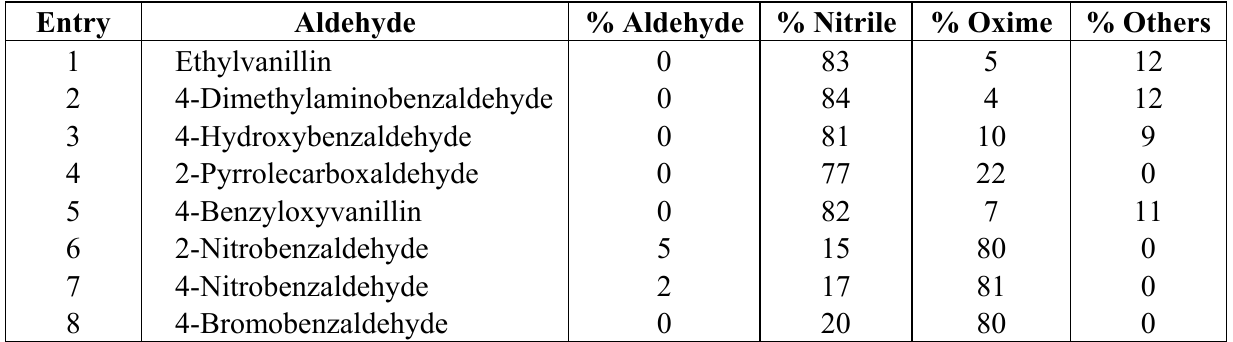
Table 2. Conversion of Aldehydes into Nitriles and Oximes in the Presence of OH·HCl and TiO under Microwave NH 2 2